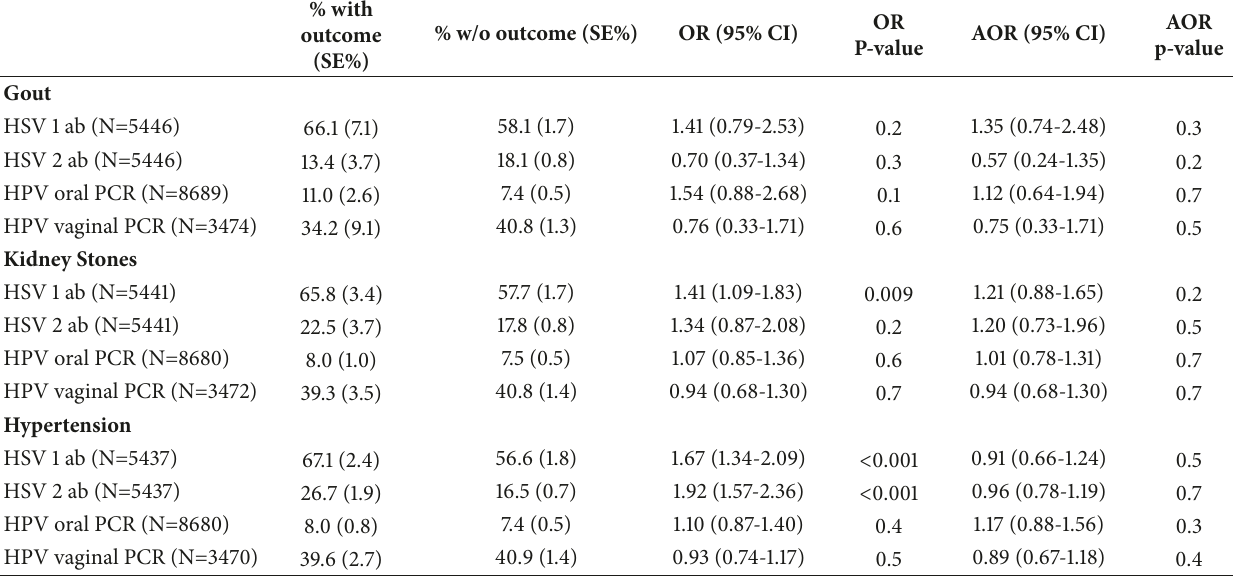
Table 3: Associations of viral markers with comparator outcomes (gout, kidney stones, and hypertension), US adults ages 20-69 (N = 9483). %